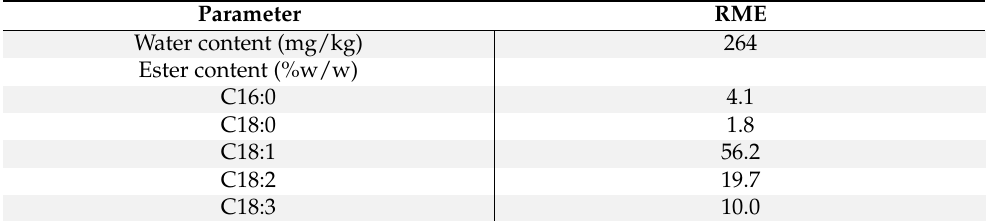
Table 1. Properties of the biodiesel used in this study.